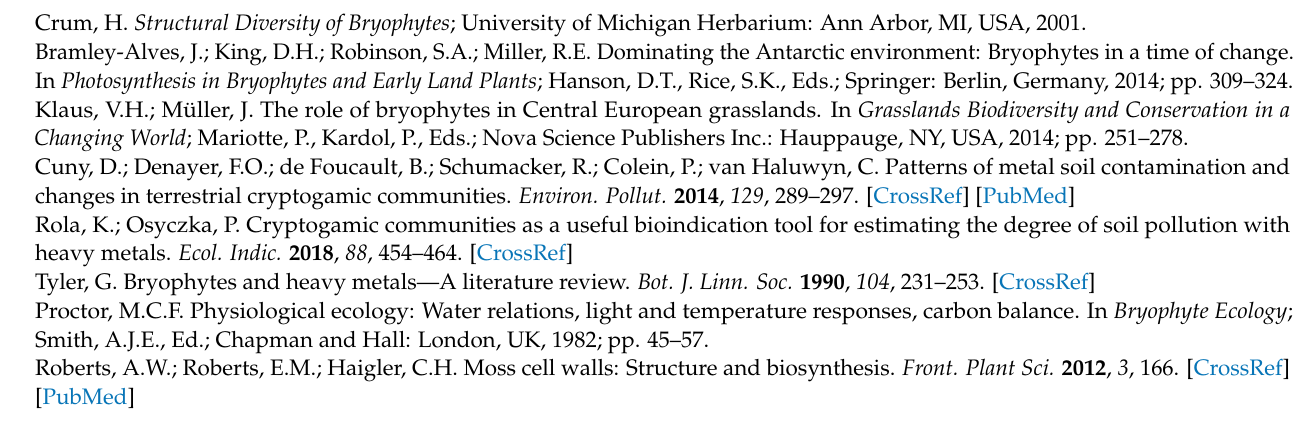
the same plots. Increasing size of the symbols indicates an increase in the number of species. The percentage of variance explained by the principal components are provided in parentheses. For detailed characteristics of soil condition classes, see Figure 2; Table S1: Results of Kruskal–Wallis tests ( p < 0.05) for significance of differences between soil condition classes in terms of the proportion of bryophyte species classified in selected ranges of ecological indicator values [53,70]. The analysis was performed only in cases when variance was present within each soil condition class. Significant differences are provided in bold ( p <